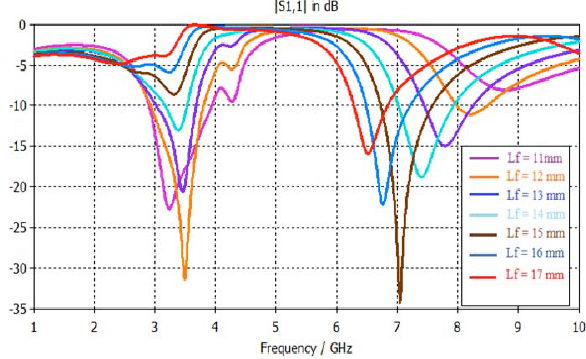
Figure 5: The return loss responses as a function of feed line length